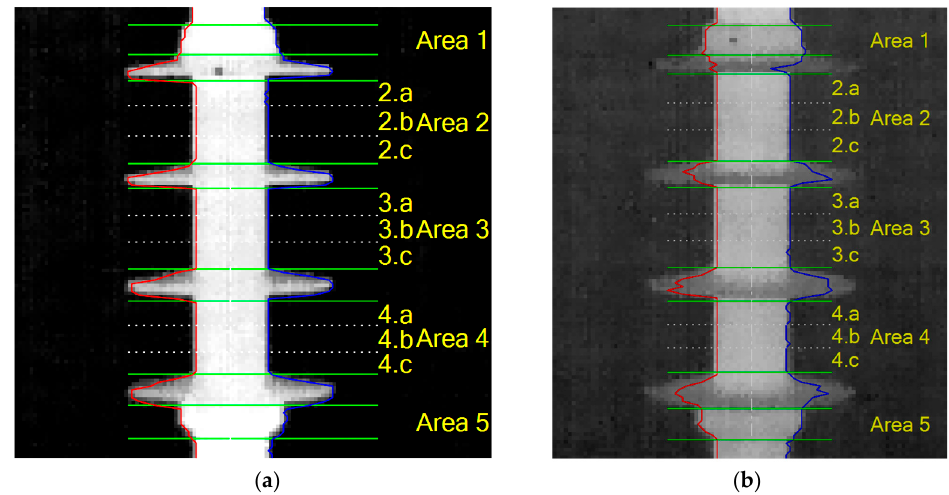
Figure 5. Automatic boundaries recognition and area selection applied to ( a ) a conventional and ( b ) a textured design.